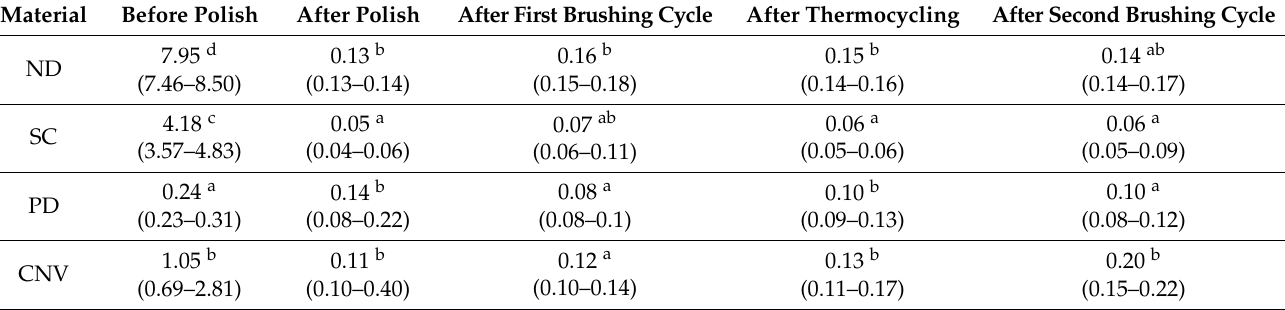
Table 2. Median and 95% confidence interval R a values ( µ m) of each material at different time